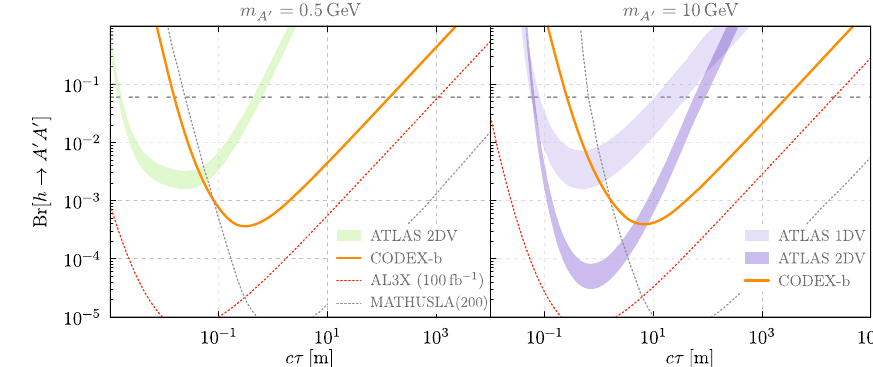
minimal model: cells for which the CODEX-b reach is known refer to the relevant figure in this document; cells denoted ‘pending’ indicate a model that may be probed by CODEX-b, but no reach projection is presently available